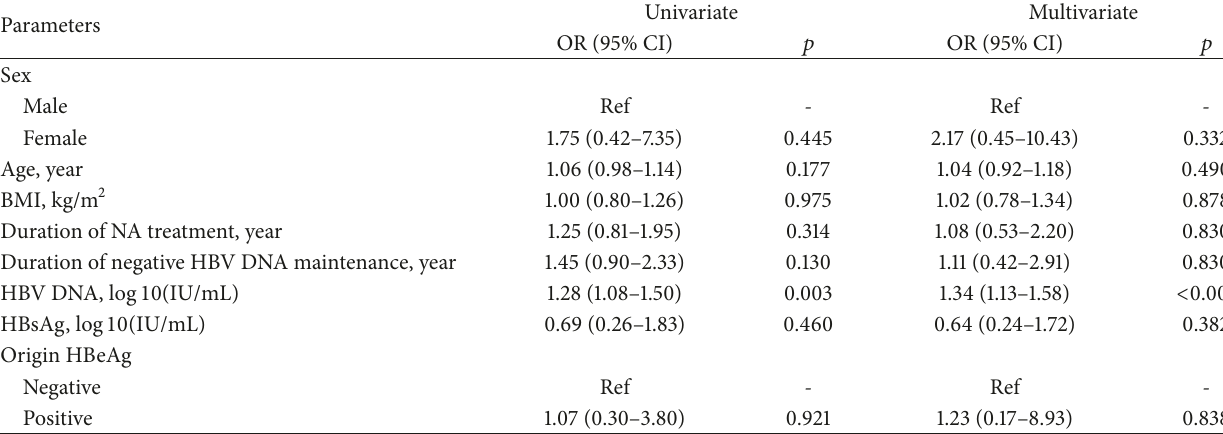
Table 3: Independent variables associated with retreatment in GEE